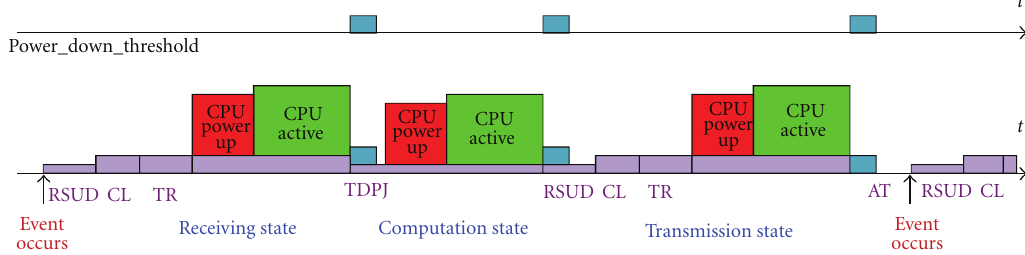
Figure 16: Energy diagram of 3 CPU power ups in one system cycle for closed model (not drawn to scale).